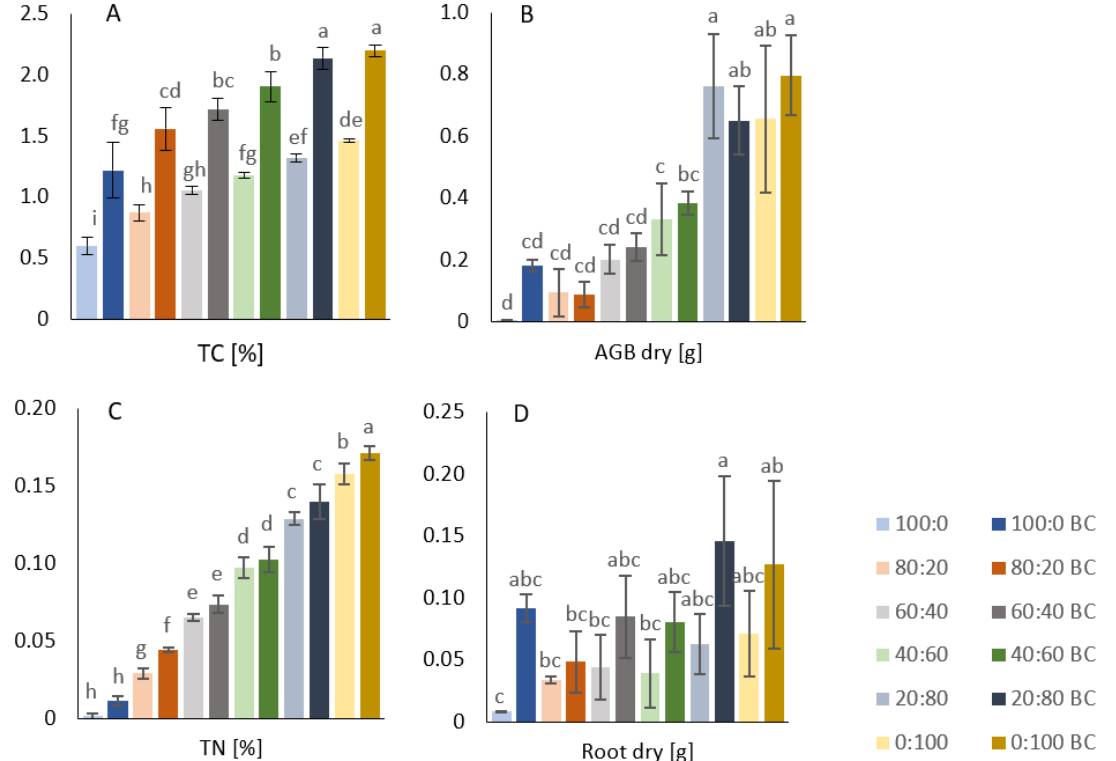
Figure 2. ( A ) Total soil carbon. ( B ) Dry aboveground biomass. ( C ) Total soil nitrogen. ( D ) Dry root biomass. Average values shown with SD (error bars), treatments amended with biochar (dark colors) and unamended treatments (light colors) are sorted by decreasing sand:soil ratios (percentages ranging from 100:0 to 0:100). Different letters indicate statistically significant differences of MANOVA at p ≤ 0.05.